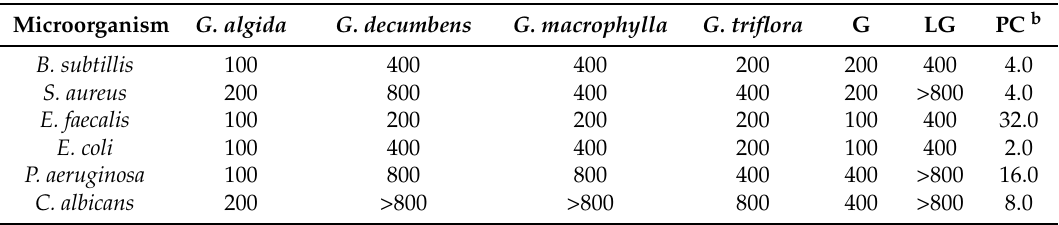
Table 4. Antimicrobial activity of four bitter gentian tea decoctions, gentiopicroside (G) and loganic acid-6 1 - O - β - D -glucoside (LG), MIC, µ g/mL a